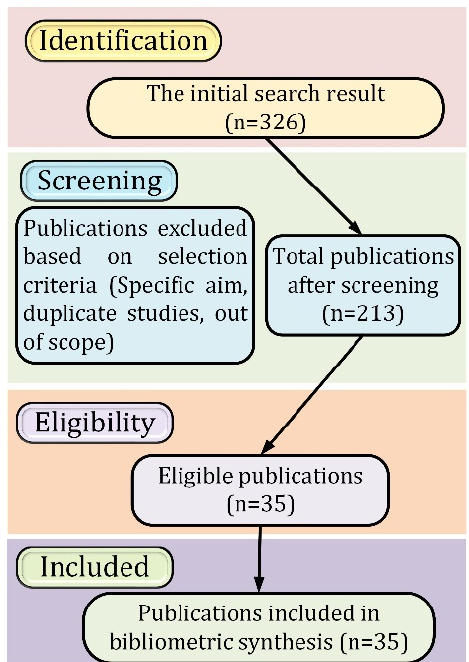
Figure 2. Inclusion and exclusion criteria of the selected studies.